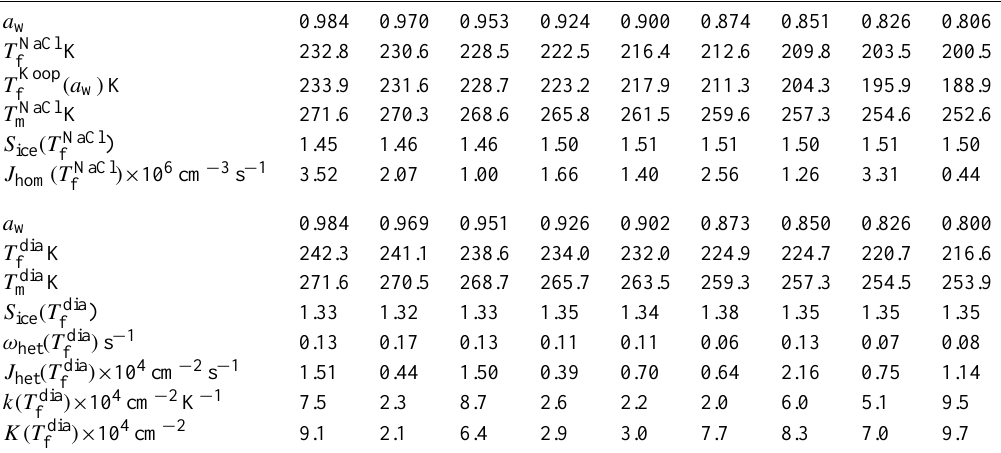
Table 1. Summary of ice nucleation parameters evaluated at median freezing temperatures for homogeneous and heterogeneous ice nucle- ation given in the top and bottom panel, respectively. Median heterogeneous freezing and mean melting temperatures of intact and fragmented diatoms were taken from Knopf et al. (2011). All other values were obtained from this